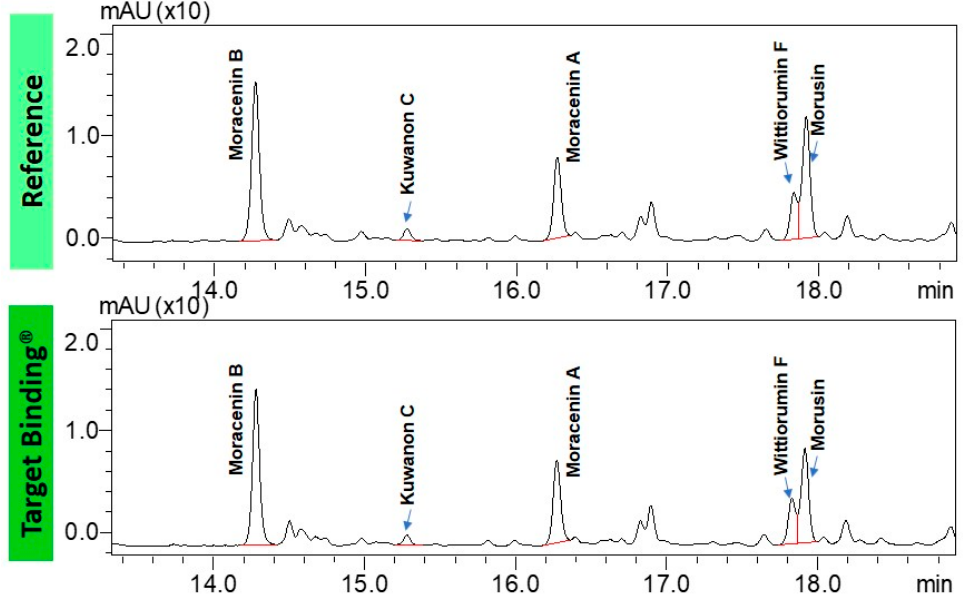
Figure 5. UHPLC chromatograms of the test mixture: Morus alba L. root extract cultivated in aeroponic system ( top ) and the supernatant containing the compounds binding to collagenase from Clostridium histolyticum ( bottom ). Table 1. Relative affinities of the components of Morus alba L. root extract to collagenase from Clostridium histolyticum .